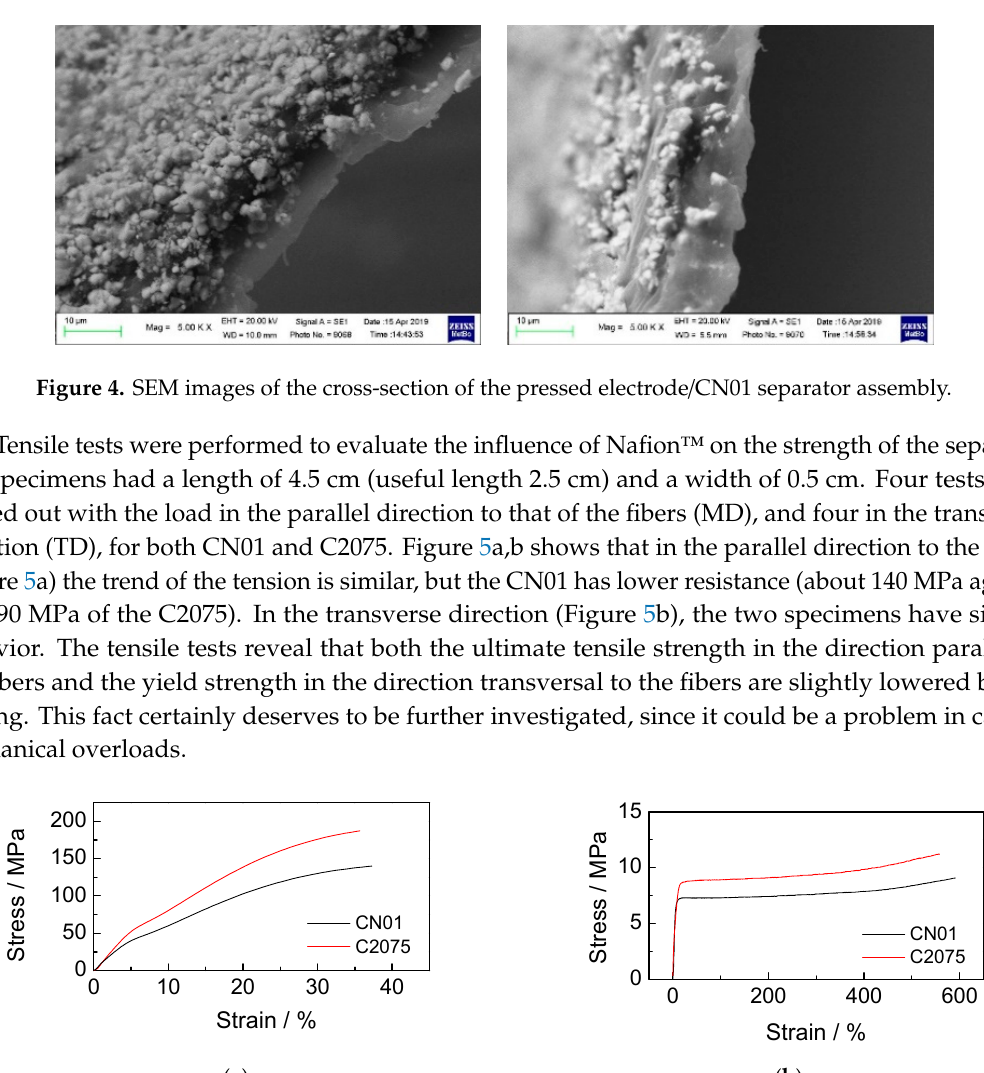
Figure 3. Images of the separators pressed onto the LNMO electrode: C2075 ( a ), CN01 ( b ), CP ( c ).